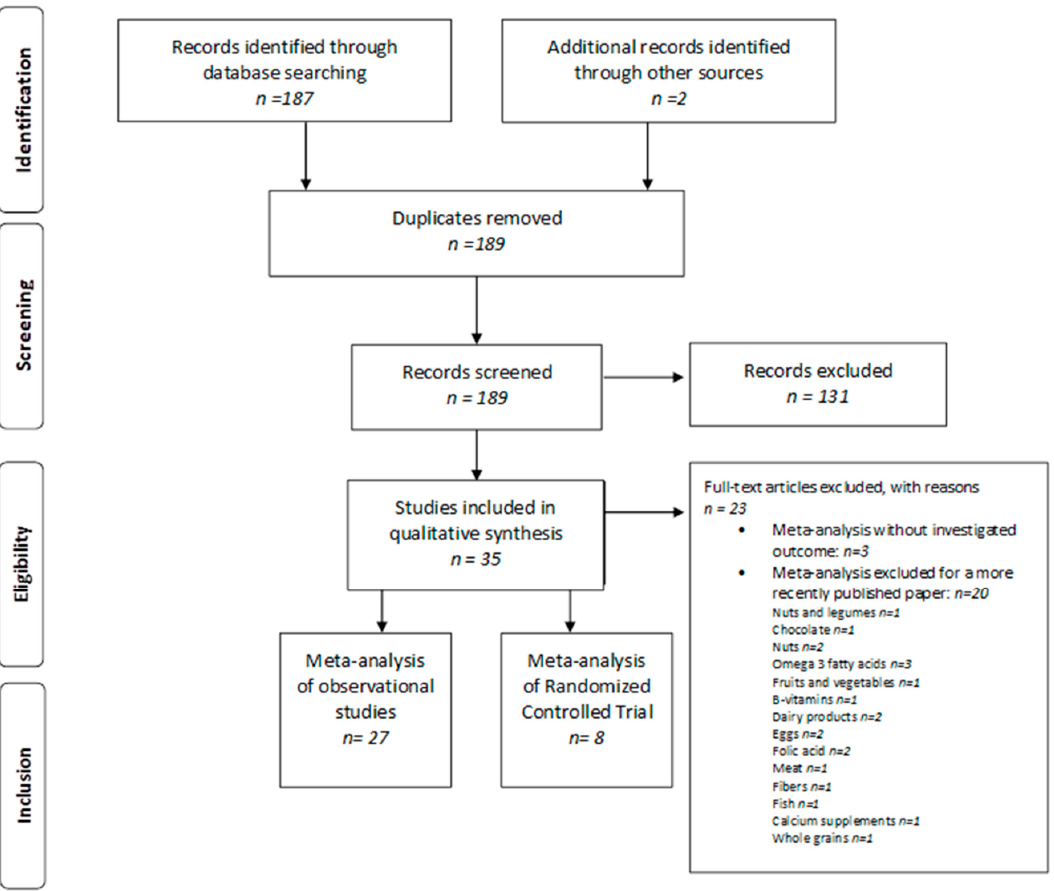
Figure 1. The preferred reporting items for systematic reviews and meta-analyses (PRISMA) flow chart.